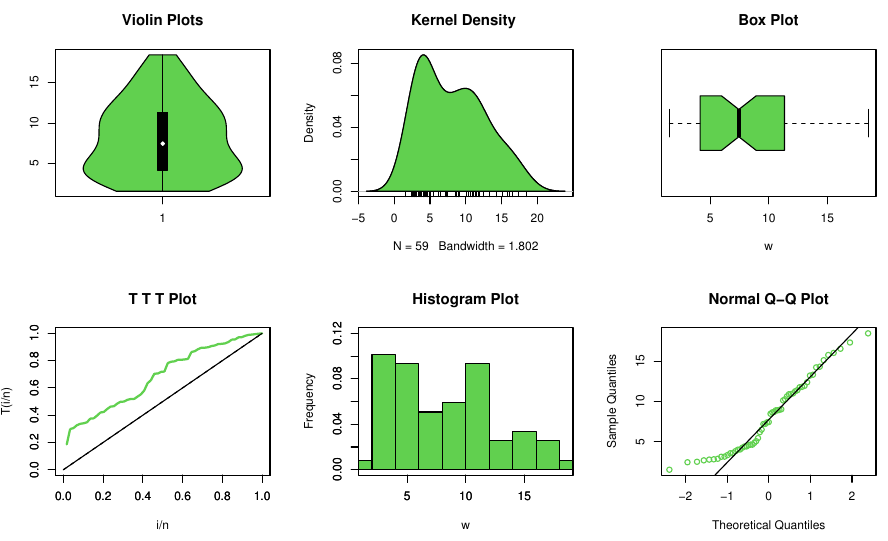
Figure 3. Non-parametric plots for data set